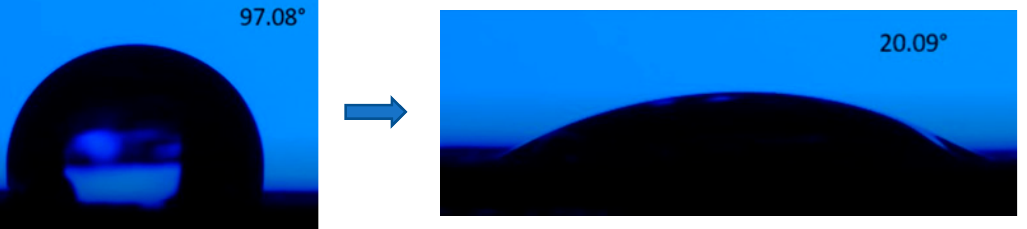
Figure 15. Aberration in contact angle measurement of the sample design type B (no. of repetition 10/frequency 40 kHz).